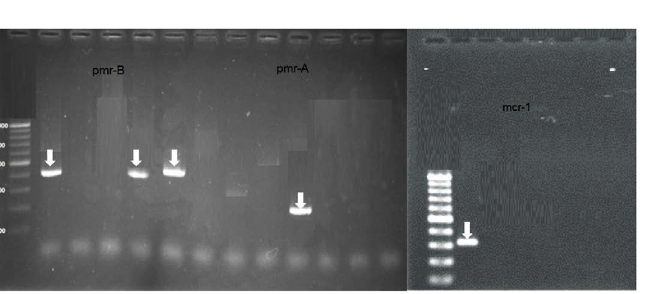
Fig. 3. Using 1000 pb ladder, isolate no 35 shows the presence of mcr-1(300bp), pmrA(170bp) and pmrB(400bp). In figure 3(a), primer 1519/1520 was used to detect the presence of pmr-B gene. In figure 3(b), primers LT2PMRA/ REV and CLRr/CLRf were used to detect the presence of pmrA and mcr-1, respectively.